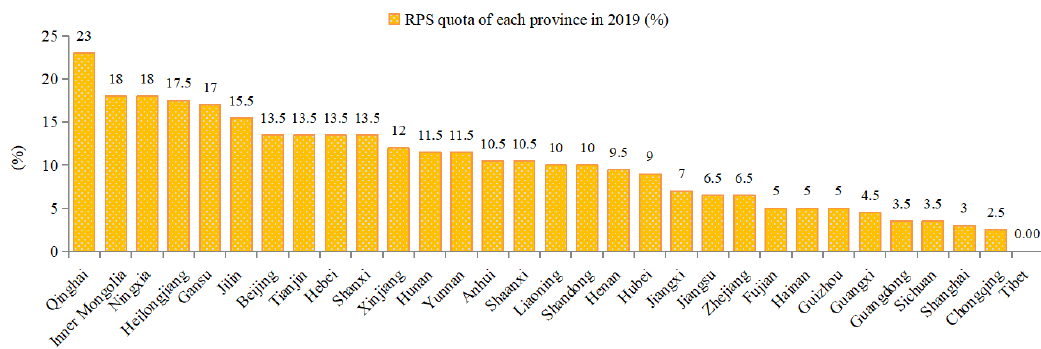
Figure 5. RPS quota of each provincial administrative region in 2019.